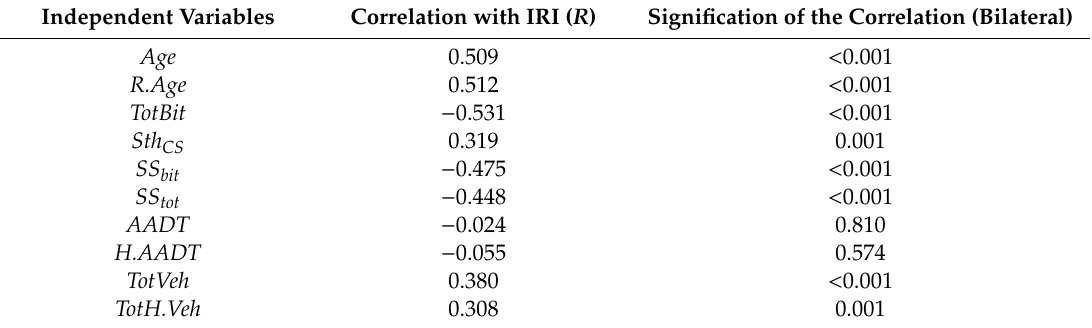
Table 3. Correlation between IRI and the independent variables (Pearson coe ffi cient, R ). Independent Variables